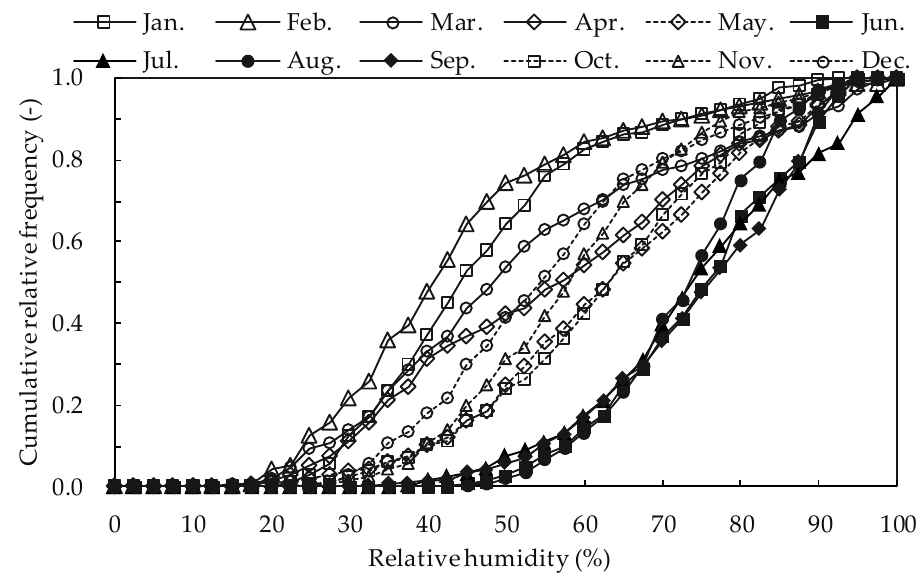
Figure 3. The correlation of the cumulative relative humidity and relative humidity per a month during a year in Tokyo, Japan.